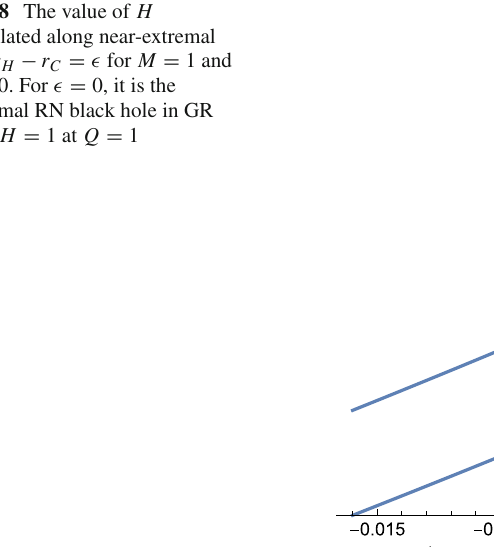
Table 2 Summary table of potential SCC violations, C 1 -SCC is always valid Spacetime/BH type Cauchy ∼ ( = ) event horizon